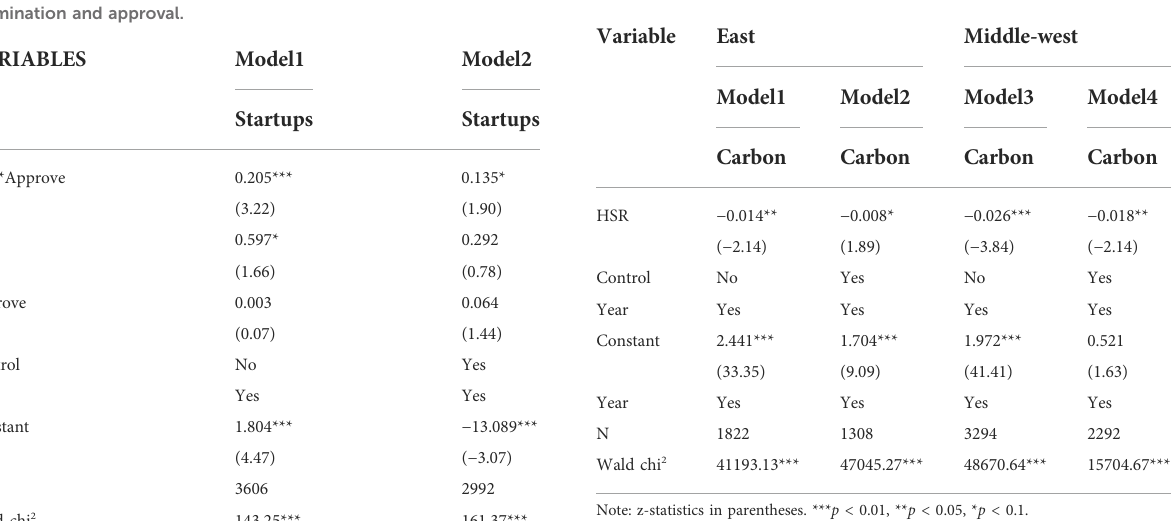
TABLE 7 Robustness check: Baseline